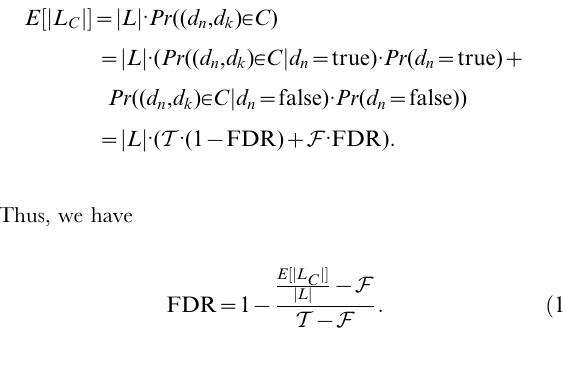
Figure S1 Sensitivity and accuracy of HHPRED + CODD